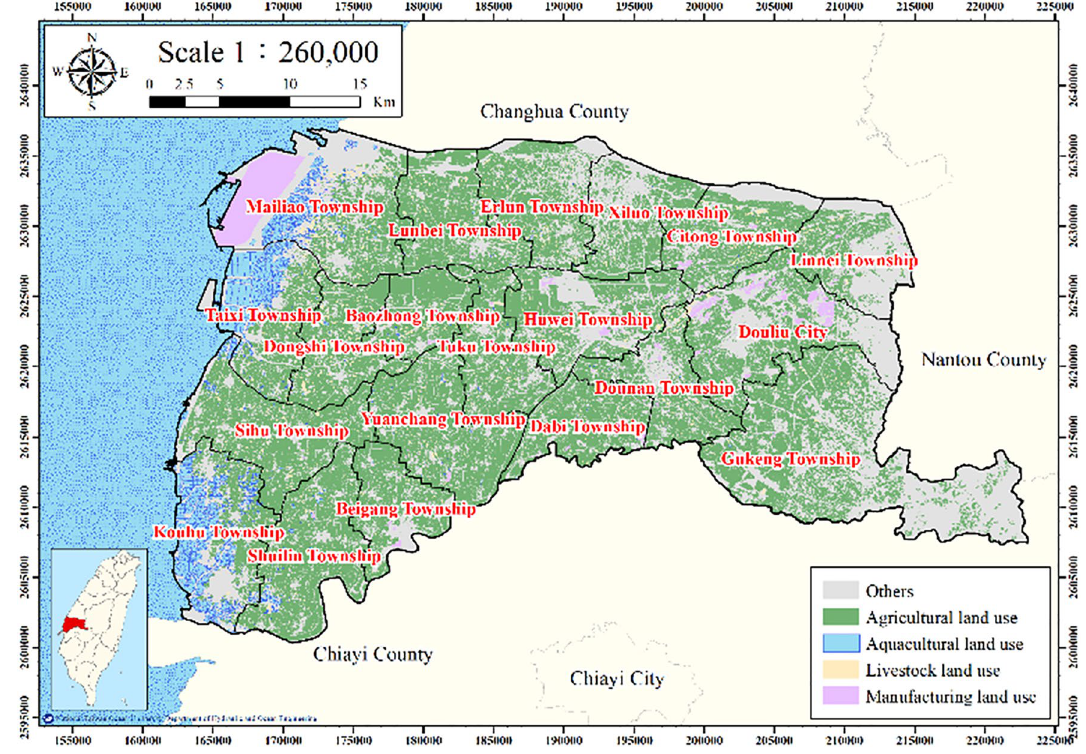
Figure 2. Land use in Yunlin County. This figure was created using ArcGIS 10.6.1